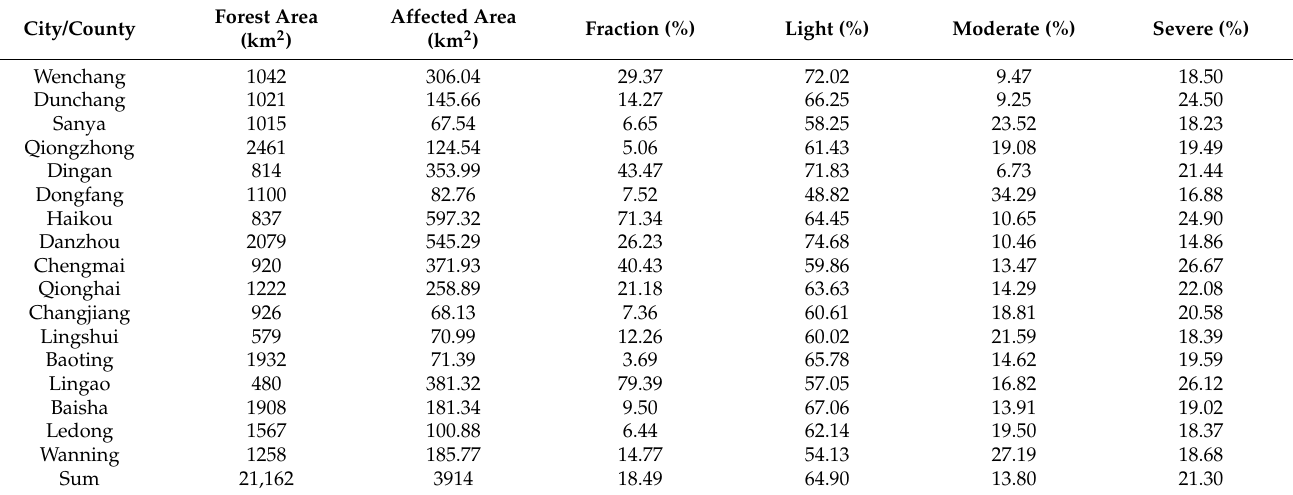
Table 5. The affected forest area and proportions of different damage severities in cities or counties of Hainan